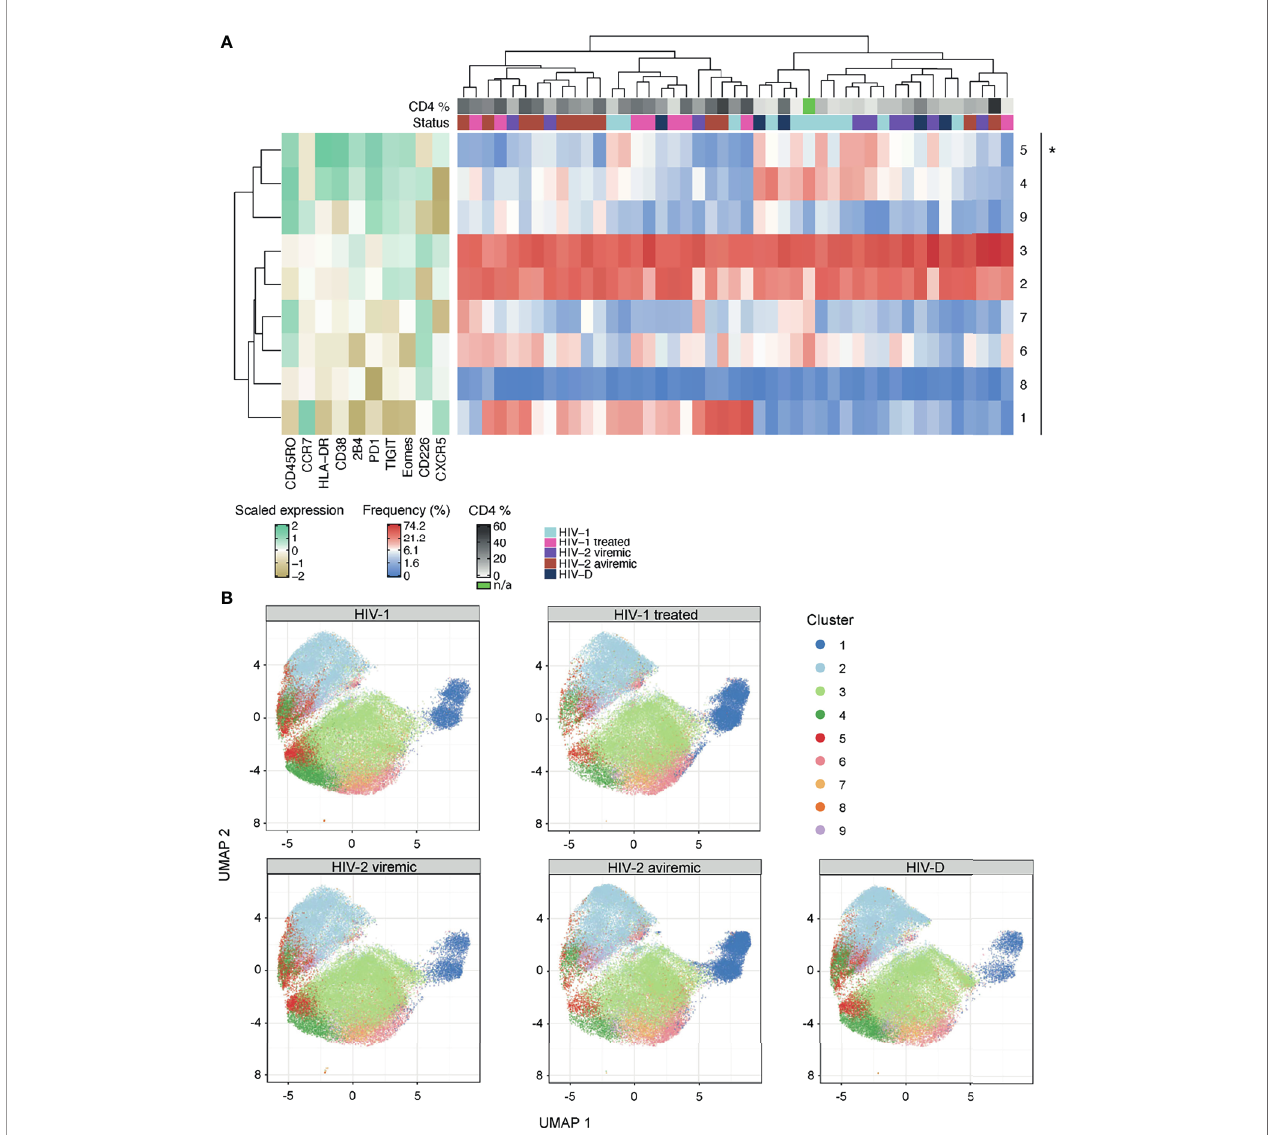
FIGURE 1 | CD8 T-cell clusters identi fi ed by FlowSOM algorithm. (A) Heatmap illustrating CD8 T-cell clusters identi fi ed by unsupervised clustering using the FlowSOM algorithm. The cells were clustered according to their expression of CD45RO, CCR7, HLA-DR, CD38, 2B4, PD-1, TIGIT, Eomes, CD226 and CXCR5. The median expression level for each marker within the clusters is shown in turquoise-brown gradient in the left panel. The red-blue heatmap indicates the frequency of each cluster per subject, with patients being hierarchically clustered based on cluster distributions. CD4% and HIV status, i.e. HIV-1, HIV-1 treated, HIV-2 viremic, HIV-2 aviremic and HIV-1/2 (HIV-D) are shown on top of the heatmap for each patient. One HIV-1 and two HIV-2 aviremic individuals were excluded from the FlowSOM analysis due to technical issues and quality of fl ow cytometry data. To the right, cluster identity and asterisks (*) indicating the cluster with statistically signi fi cant differences identi fi ed between aviremic and viremic HIV-2 infection. Statistical differences were determined using a negative binomial generalized linear model and group-wise comparisons were individually FDR-controlled using the Benjamini-Hochberg method. (B) UMAP generated using a sample of 50,000 cells from each HIV status category (a total of 250,000 cells) based on scaled expression of the ten clustering markers. Samples within each category were sampled approximately equally. The plot is faceted by HIV status and colored by FlowSOM